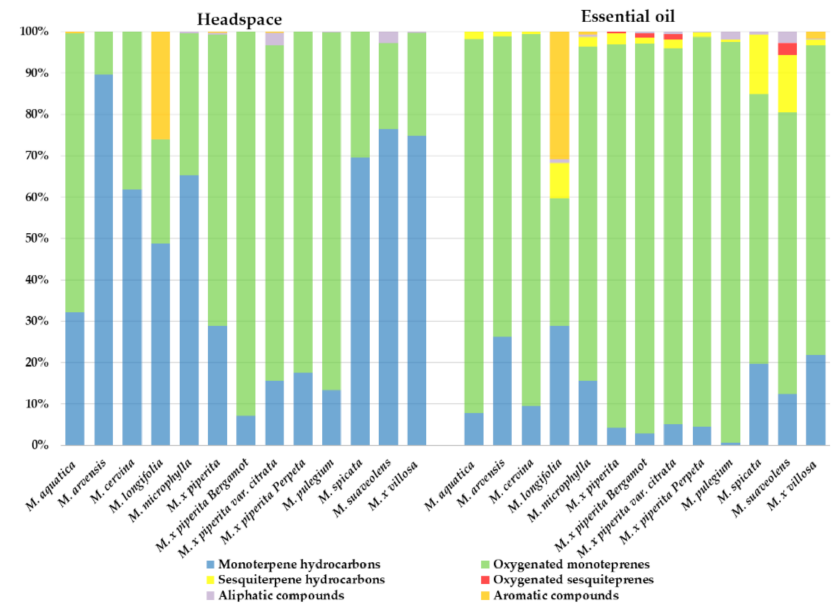
Figure 3. Volatile profiles of selected Mentha